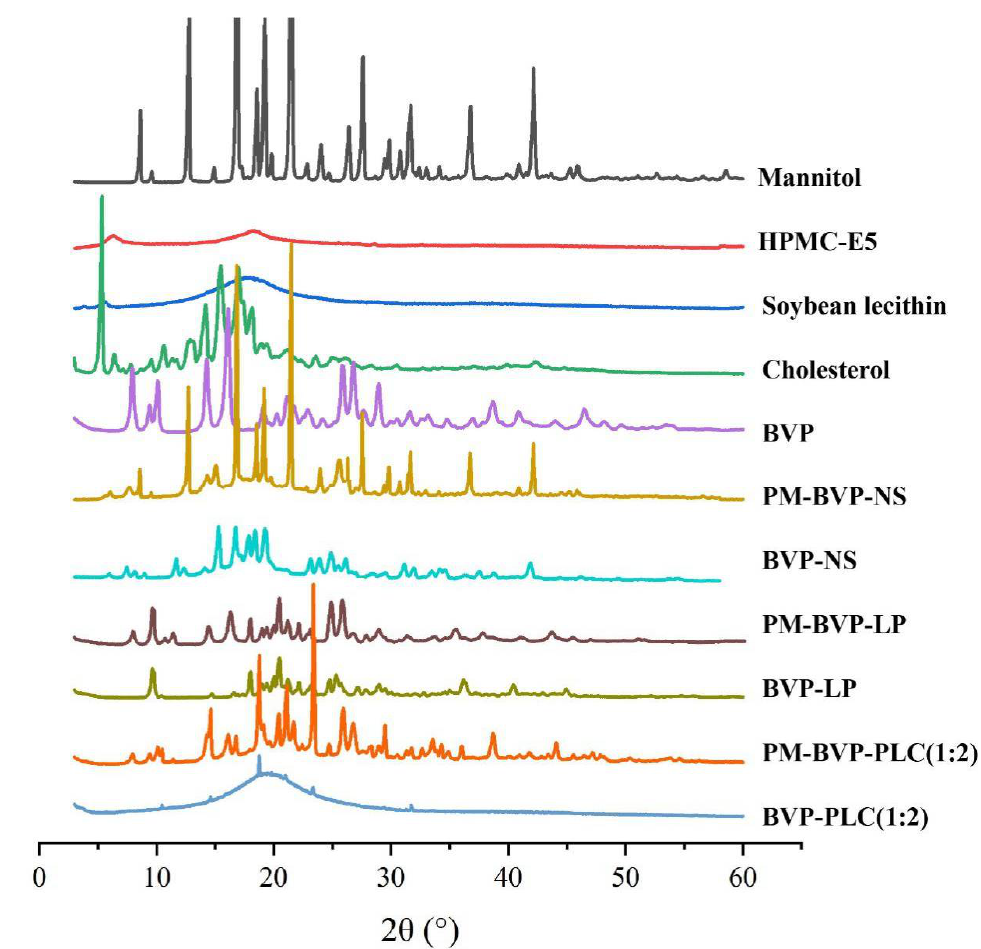
Figure 8. Powder X-ray diffraction (PXRD) pattern of mannitol, HPMC-E5, soybean lecithin, cholesterol, BVP, PM-BVP- NS, BVP-NS, PM-BVP-LP, BVP-LP, PM-BVP-PLC (1:2) and BVP-PLC (1:2).